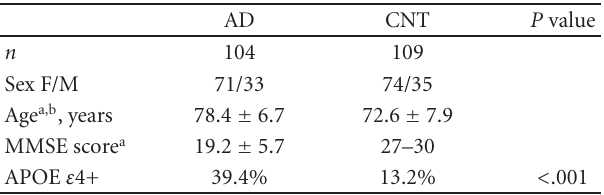
Table 2: Nucleotide variants in GPR3 promoter and coding regions and their allele frequencies in AD patients and